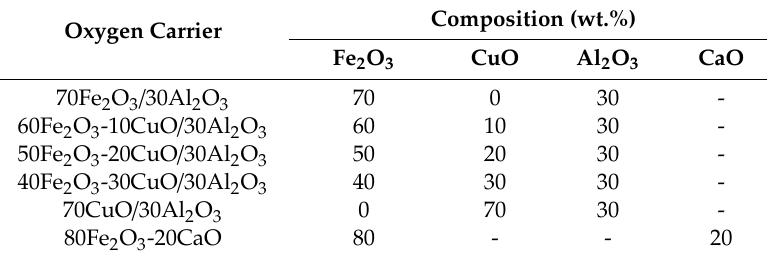
Table 2. Chemical compositions of the oxygen